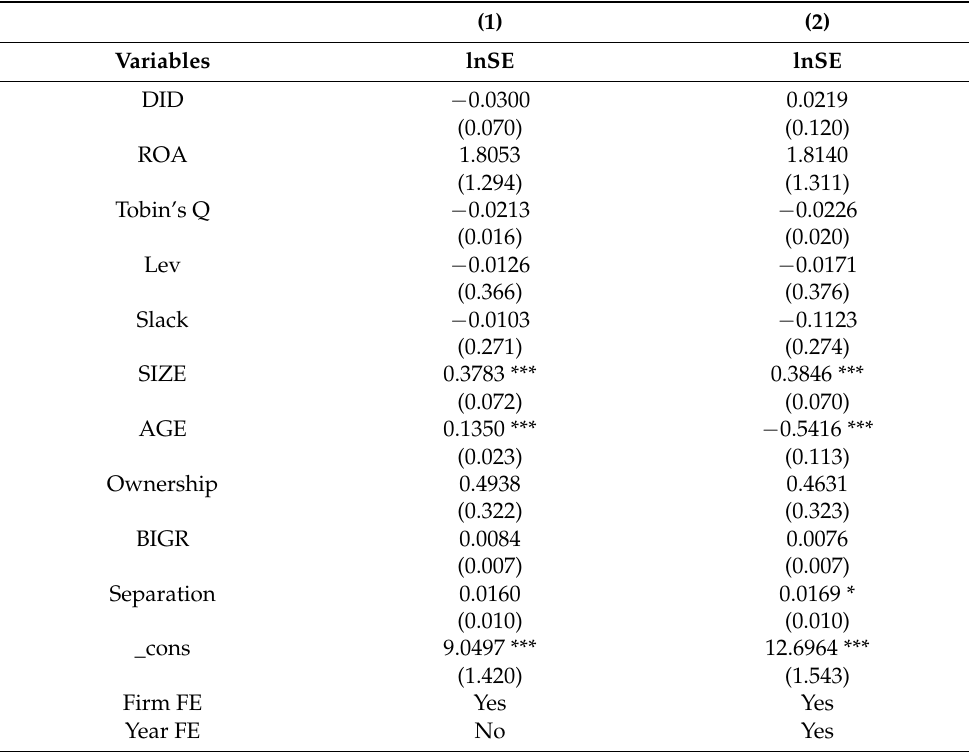
Table 6. Placebo